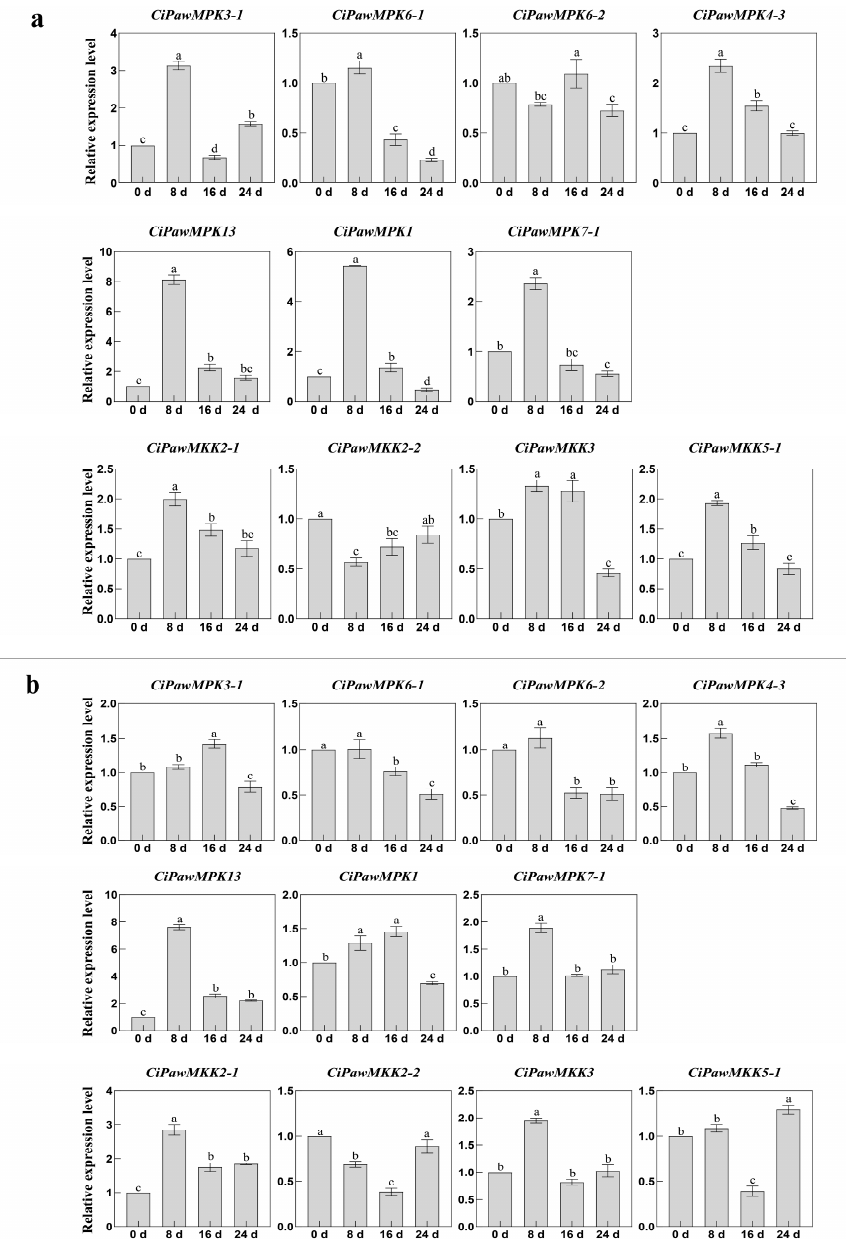
Figure 11. Gene expression patterns of MPK and MKK in pecan under NaCl ( a ) and 20% PEG ( b ) treatments. The reference gene is the actin gene ( CiPaw.03G124400 ). The horizontal coordinates indicate the different time points sampled and the vertical coordinates indicate the expression level of the genes. According to Duncan’s multiple range test, it was judged whether there was a significant difference in the expression levels at different time points ( p < 0.05), and the difference results were denoted by lowercase letters. Error bars represent mean ± SE obtained from three biological replicates.